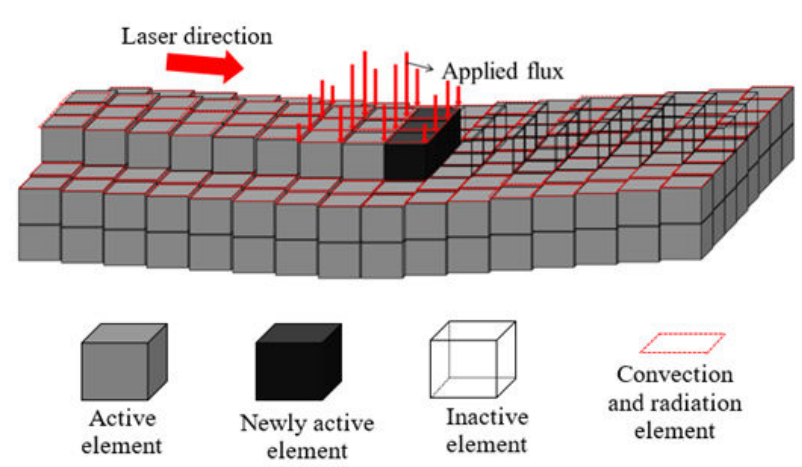
Figure 8. Scheme of element birth and death technique along the curved surface, updated state when the laser has moved (Reprinted with permission from ref. [38]. Copyright 2017 Elsevier).